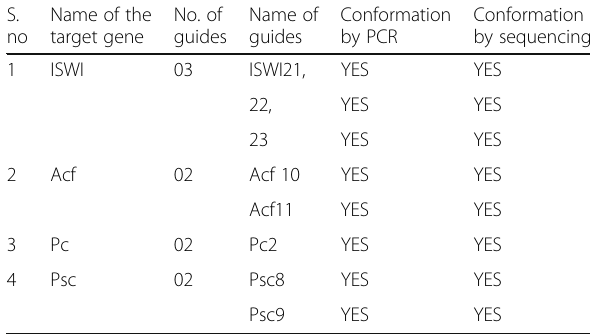
Table 3 CRISPR-CAS9 constructs to knockout TrxG and PcG